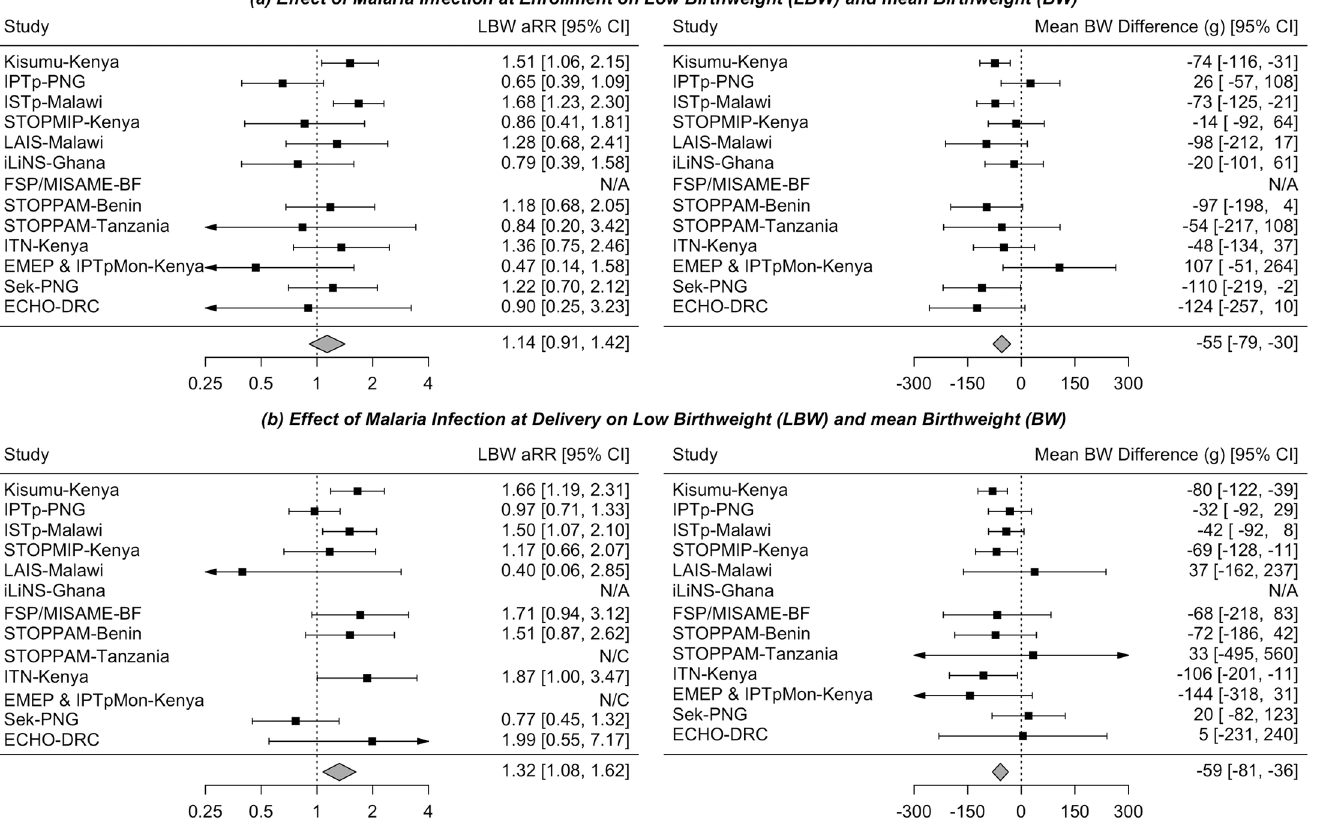
Fig 3. The independent effectsof (a) malaria infection at enrollment and (b) malaria infection at delivery on risk of low birthweight and mean birthweight among women enrolled in 1 of 13 studies from the Maternal Malaria and Malnutrition (M3) initiative. The inverse probabilityof treatment weighted(IPTW) estimates controlledfor confounding betweenmalaria at enrollment and low birthweight (LBW) by maternal age, gravidity, area of residence, mid-upper arm circumference at enrollment, and HIV infection. IPTW estimates controlledfor confounding betweenmalaria at delivery and LBW and additionallycontrolled for anemia and numberof doses of antimalarialintermittent preventive therapy receivedduringpregnancy. aRR, adjustedrisk ratio; BF, Burkina Faso; BW, Birthweight; CI, Confidenceinterval; DRC, Democratic Republicof the Congo; LBW, Low birthweight;N/A, not available; N/C, no model convergence; PNG, Papua New